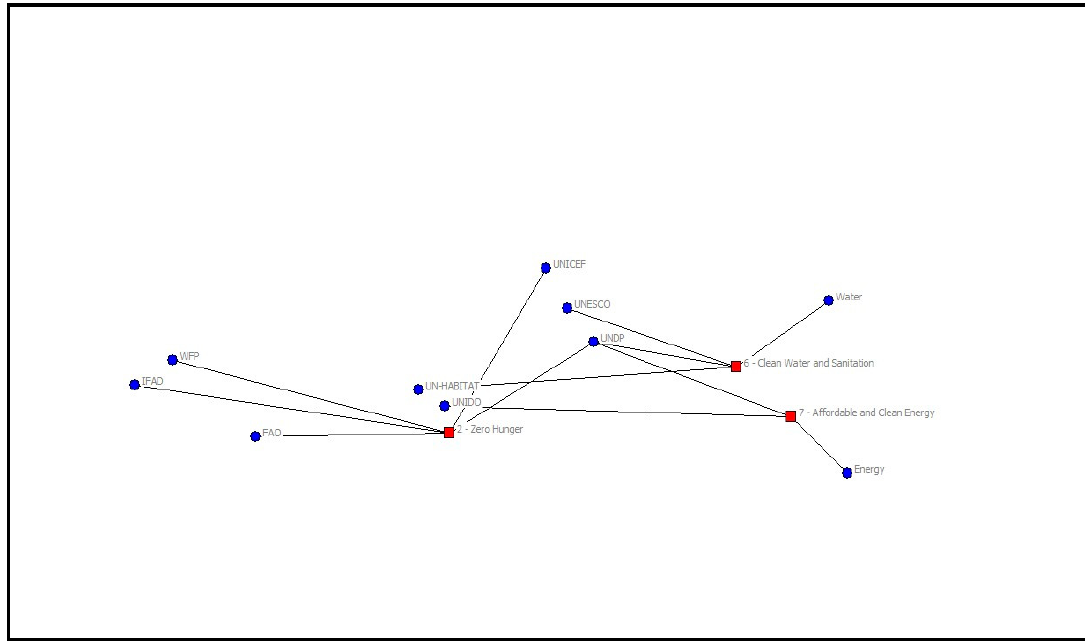
Figure 6 . SDGs—FEW network. Figure 6. SDGs—FEW